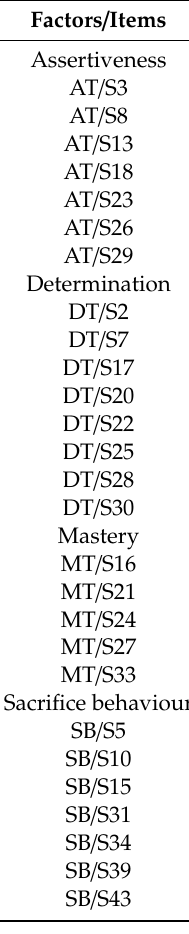
Table 4. Standardised factor loading, Cronbach’s alpha of the final measurement model of SCS-M, 33